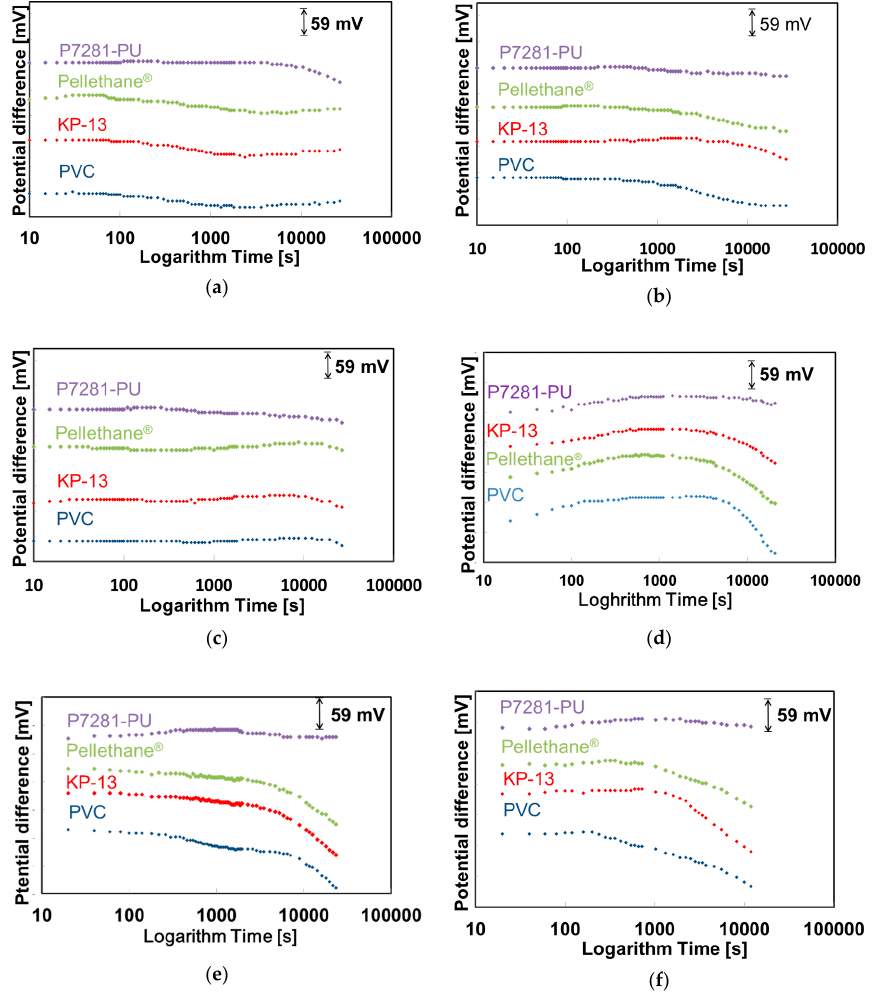
Figure 3. Initial drift of NO 3 -ISFETs ( a ) in standard solution; ( b ) in standard solution with 0.5 wt % mucin; ( c ) in standard solution with CO 2 bubbling; ( d ) in artificial saliva; ( e ) in saliva via Salivette; ( f ) in whole saliva (non-pretreatment).